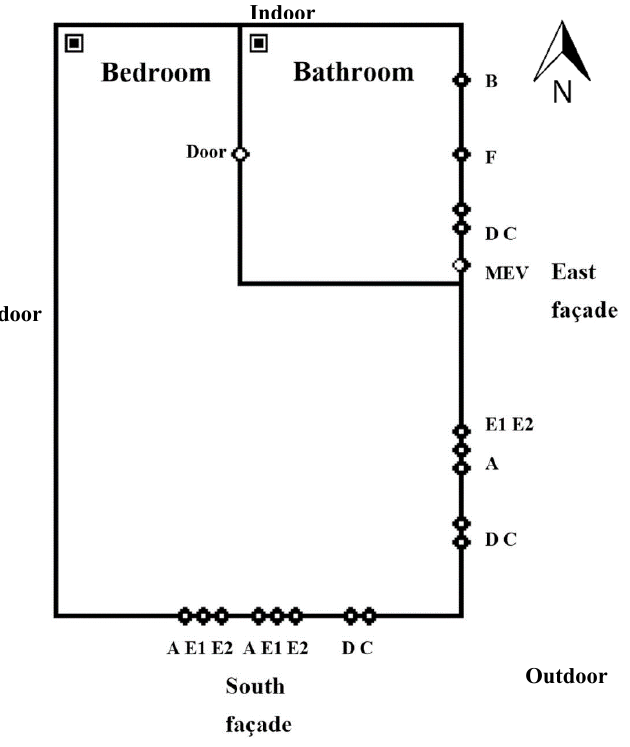
Figure 3. Representation of the CONTAM model of the most comprehensive scenario (Scenario 3) with mechanical extraction ventilation (MEV) added. For leakage type code, refer to Table 5. For additional characteristics on the air leakage paths and respective weight on the total ELA, refer to Table 6.